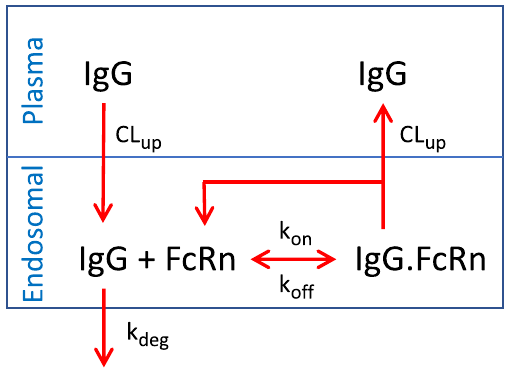
Figure 1. Schematic representation of the model formulating the interaction of IgG with the FcRn receptor, R 1 = k 1 C k 1 = CL up / V e